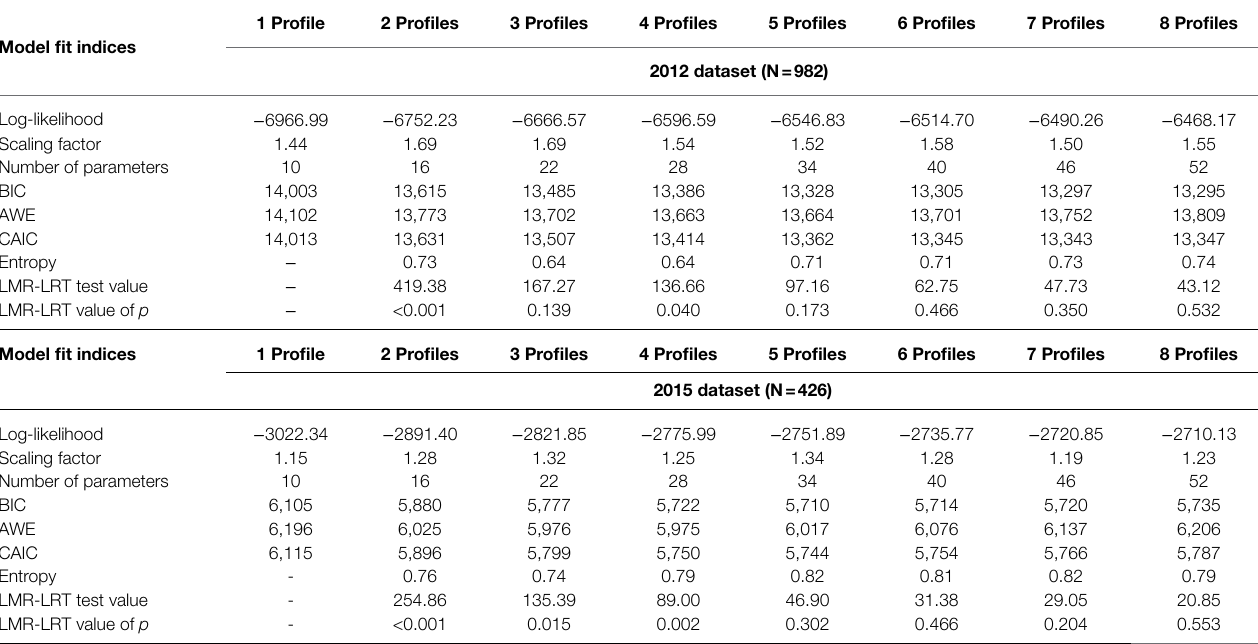
TABLE 2 | Results of the latent profile